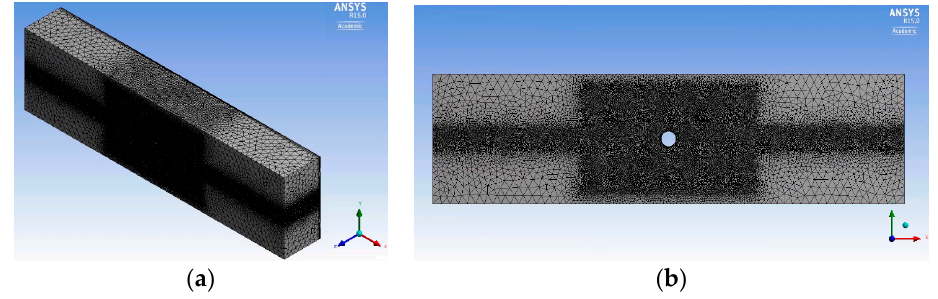
Figure 6. An example of meshing results: ( a ) isometric view; ( b ) top view.